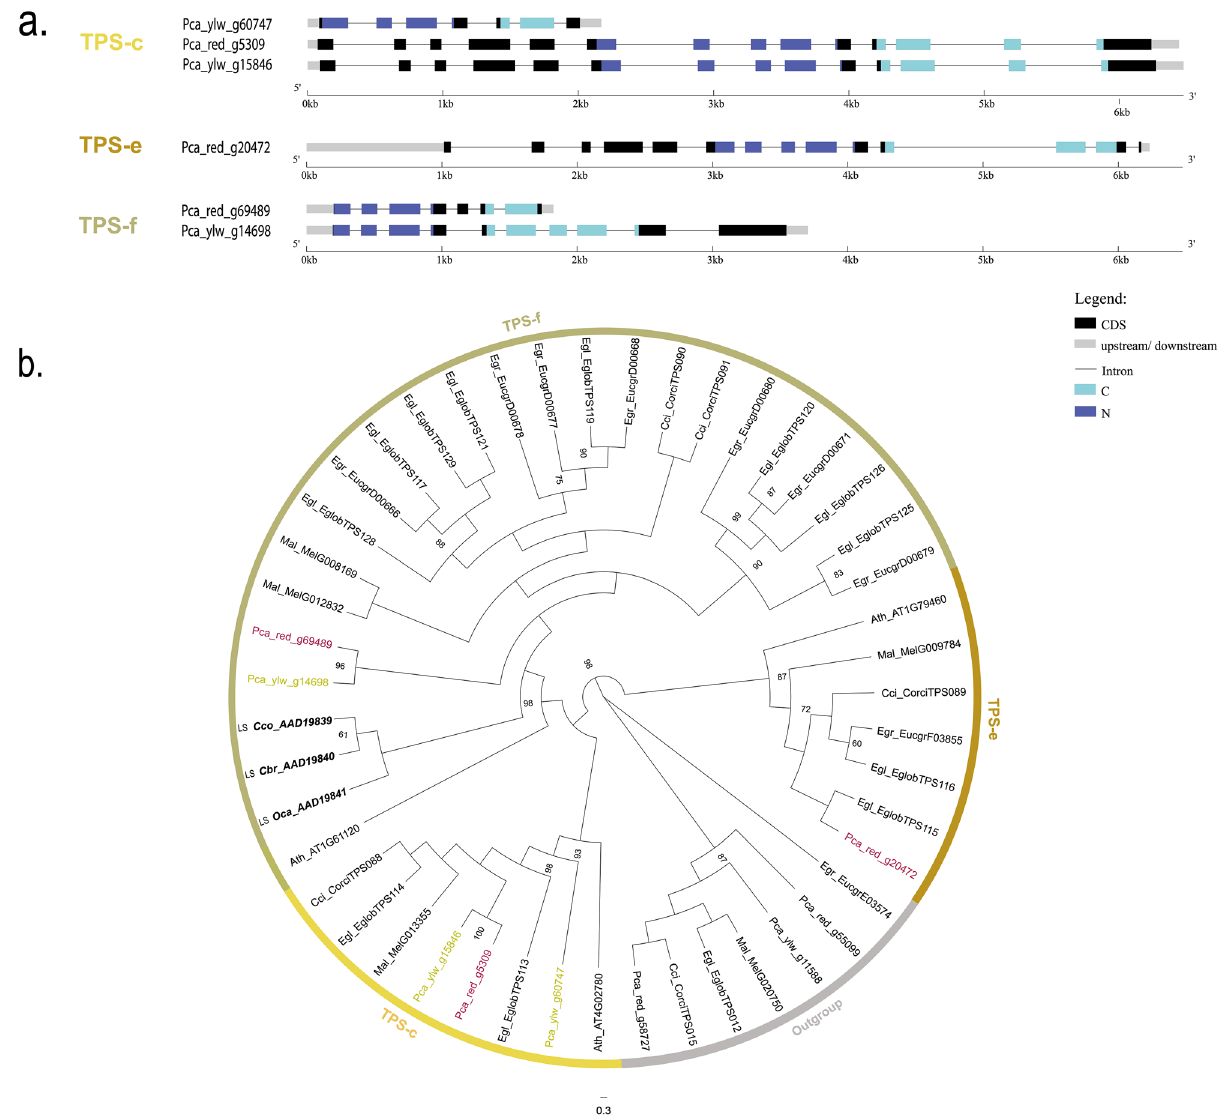
Figure 2. Phylogeny and gene structure of the TPS from primary metabolism. ( a ) Conserved domains in TPS genes and their consensus sequences from P. cattleyanum. ( b ) Phylogenetic tree of the Tps-c, Tps-e and Tps-f subfamilies from P. cattleyanum genome and representative TPS from other Myrtaceae species. This tree was constructed through maximum likelihood methods comparing the red and yellow morphotypes (Pca_red and Pca_ylw), C. citriodora subsp. variegata (Cci), E. grandis (Egr), E. globulus (Egl), M. alternifolia (Mal) and A. thaliana (Ath). Functional characterized terpene synthases are written in bold. Bootstrap values supported by > 60% are noted by number. A few species from TPS-a clade were used as the